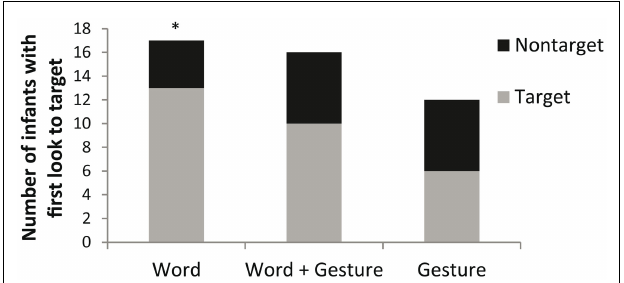
FIGURE 5 | Number of infants with a first look to the target on the first question of trial 1. Note: Asterisk indicates significant difference from chance, p <